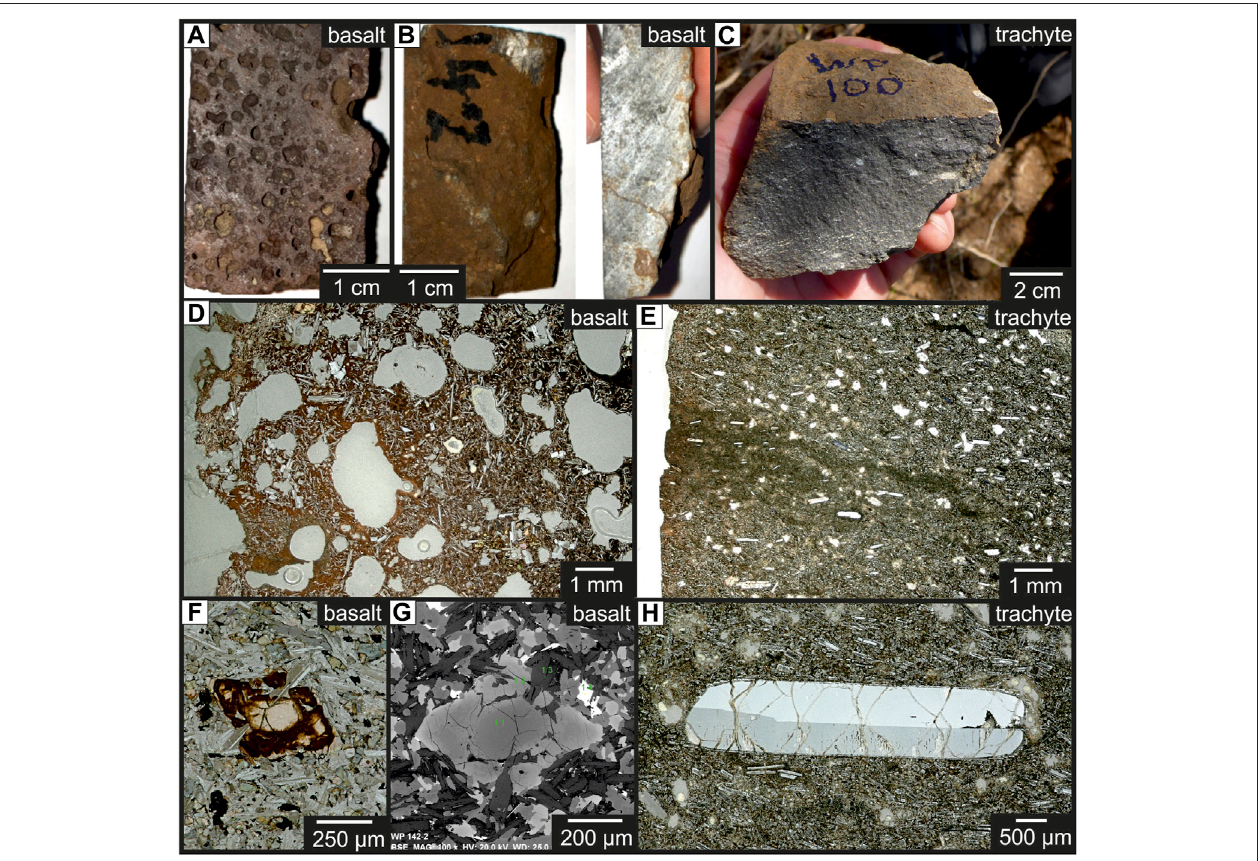
FIGURE3| ( A – C) Photosofhandsamplesof (A) abubblerich,completelyweatheredbasalt, (B) acompact,stronglyweatheredbasaltintopview (left) andalong a section (right) , (C) a compact trachyte with a thin brown weathering crust. (D – H) Microscopic images of (D) a strongly weathered, bubble-rich basalt with a high proportionofwhiteneedle-shapedfeldsparinareddish-brownalteredmatrix, (E) trachytecontainingelongatedfeldsparcrystalsinavery fi ne-grainedgroundmass,with a thin, near-surface, brown weathering crust (left) and in the middle a greenish-brown area indicating the course of a fl uid path running from the left (surface of the rock) into deeper (several mm) parts of the rock. Olivine within a moderately weathered basalt, (F) showing strong alteration (dark brown areas) along the grain boundaries and along the cracks (thin section) and (G) a BSE-image of the same olivine crystal; the darker gray area represents the primary olivine with Mg-rich composition and the brighter gray parts of the crystals indicates Fe-enrichment within the altered section of the mineral. (H) One large feldspar crystals within trachyte with weak alteration speci fi cally along the cracks.